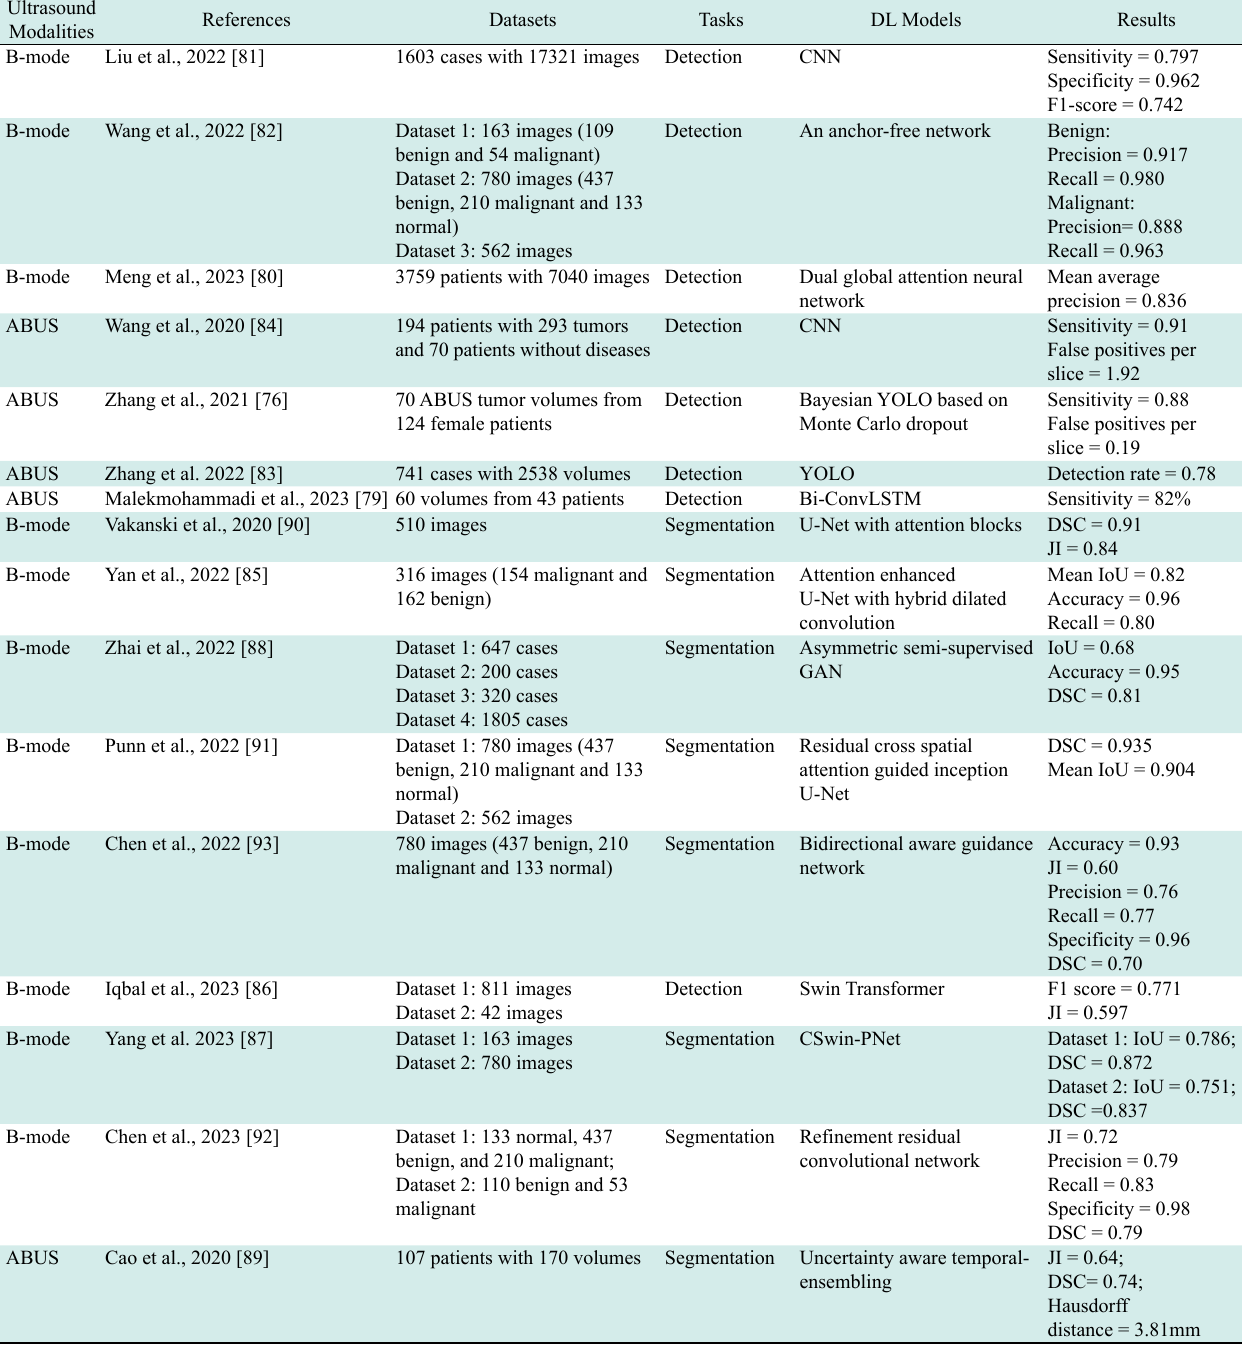
Table 2 Deep learning for breast tumor localization in